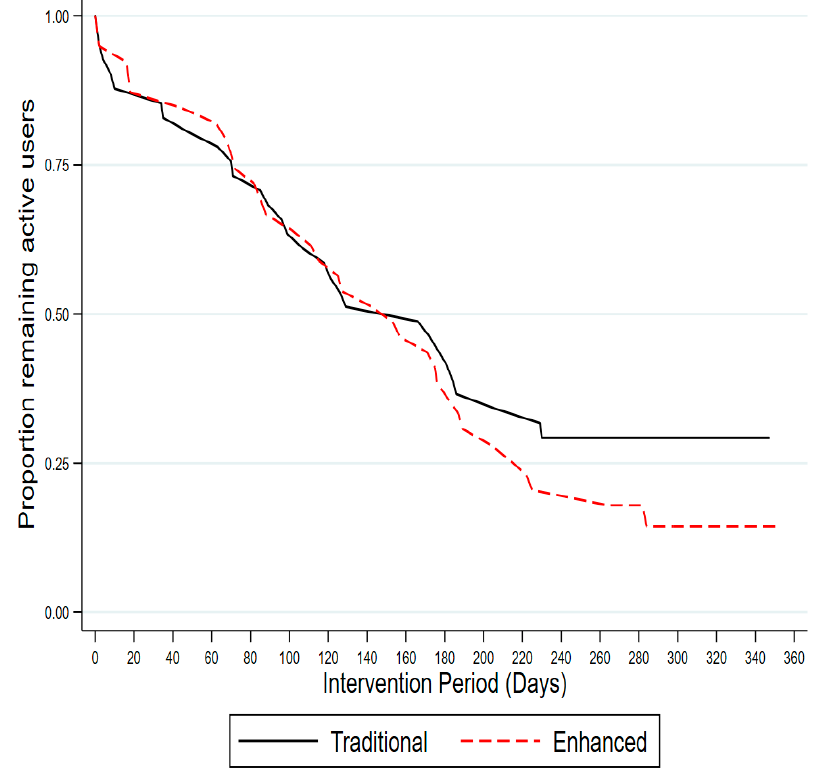
Figure 5. Kaplan–Meier estimates of the survival distribution for time to non-usage attrition by group.